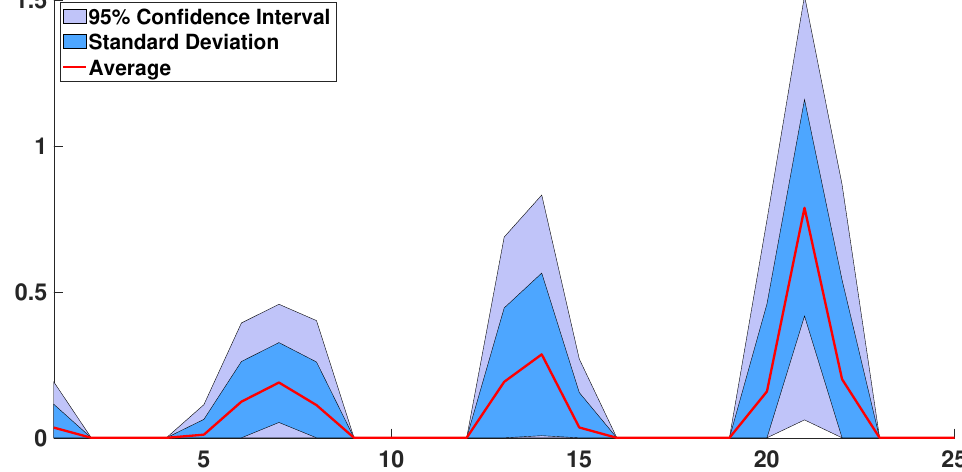
Figure 16. In this figure, we consider the case n = 25. We plot the distributions of daily basic reproduction numbers d (cid:55)→ R 0 ( d ) = R 0 ( d ) λ d , where R 0 ( d ) is the red curve in Figure 1